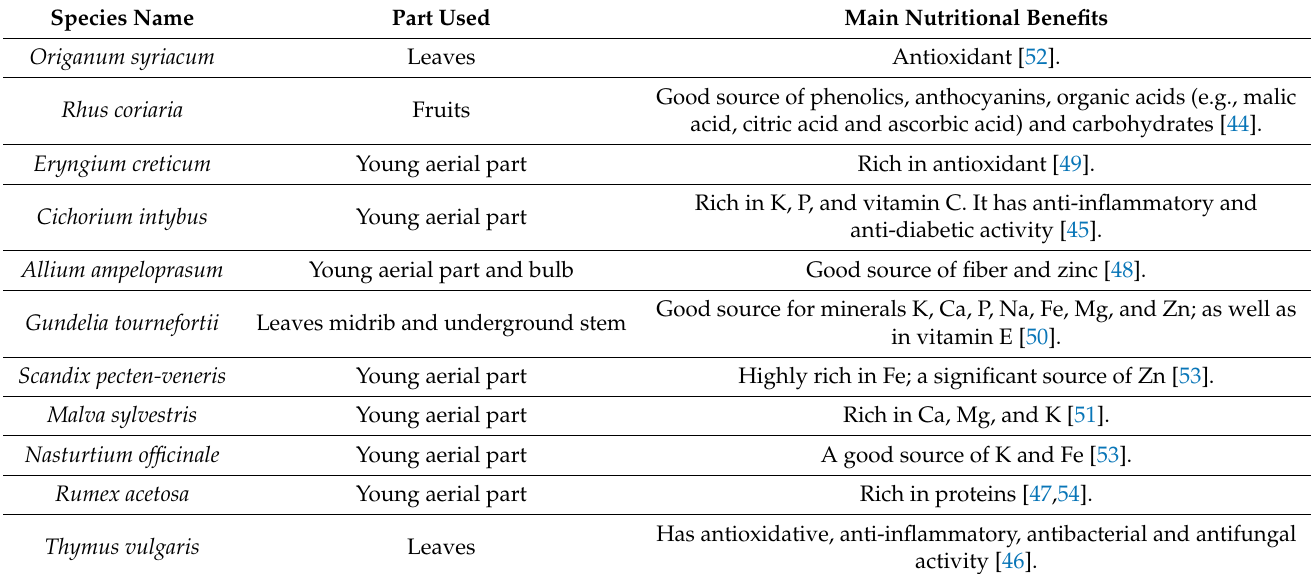
Table 2. Main nutritional benefits of WFPs, which are among the most reported in the current